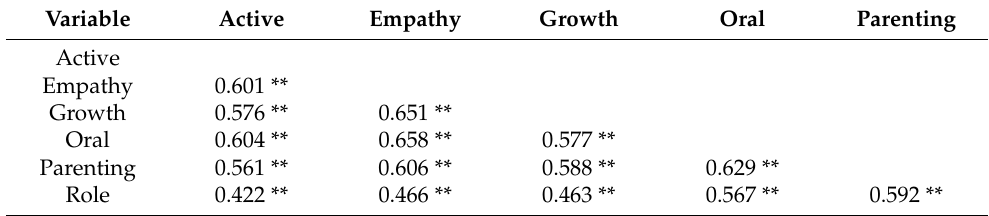
Table 3. Correlations between belief measure scale scores.